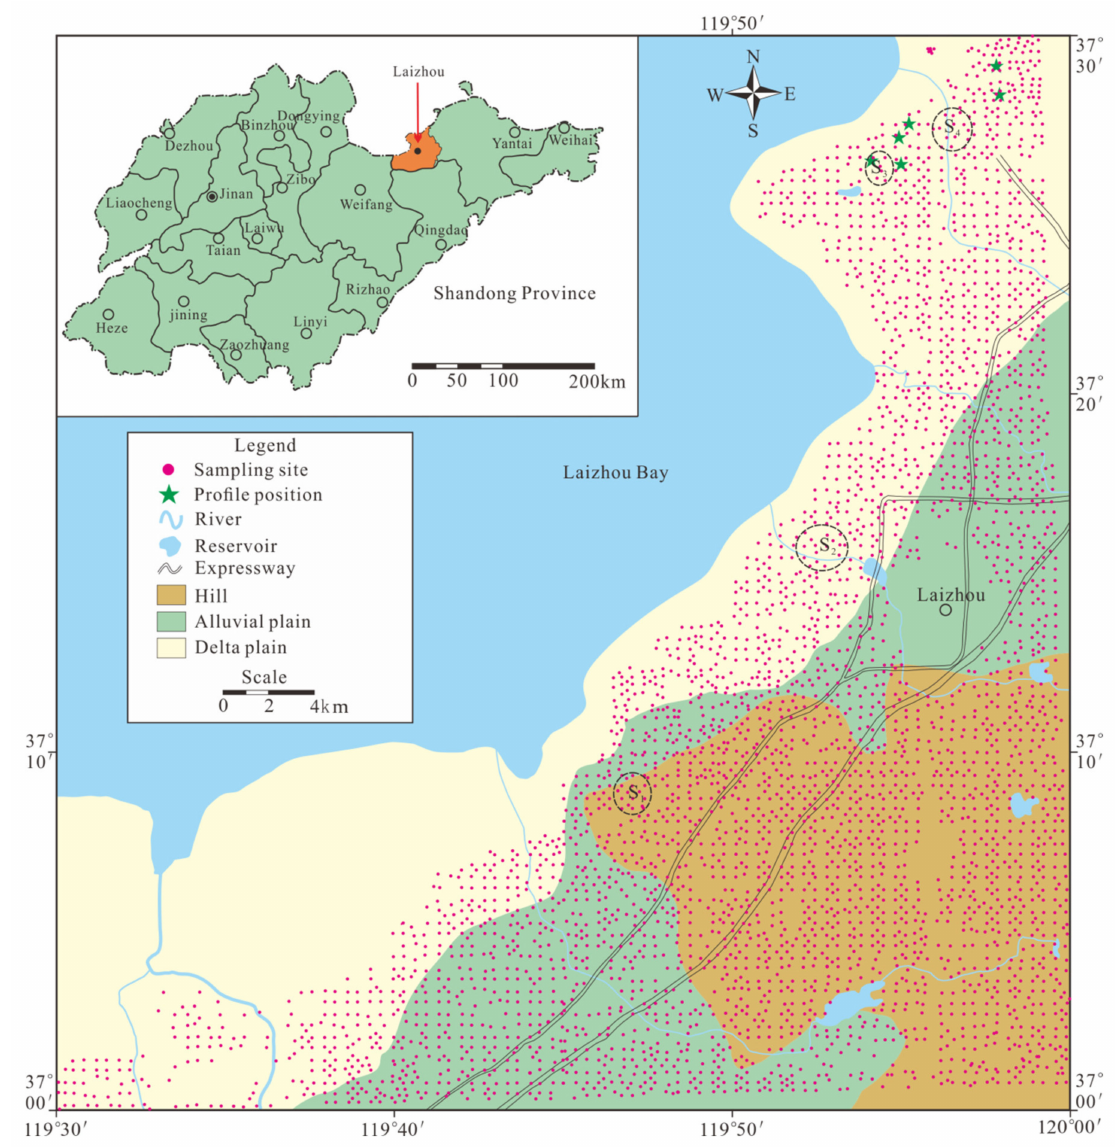
Figure 1. Geographical location of study area with indication of the sampling sites (the geographical location map is derived from the administrative zoning map of Shandong Province,